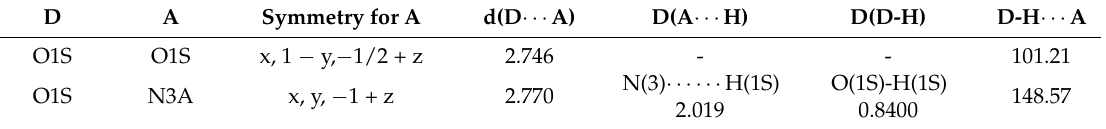
Table 2. Hydrogen-bonds D ¨¨¨ H ¨¨¨ A (Å) and D ´ H ¨¨¨ A angles ( ˝ ) of compound I .